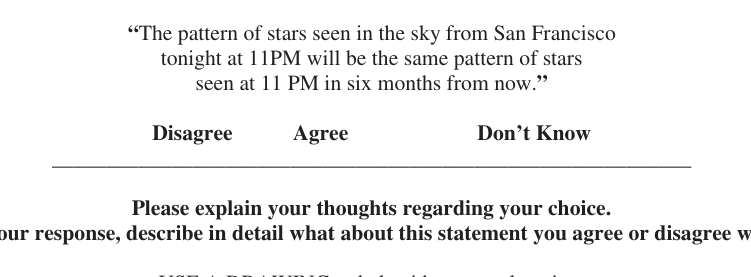
FIG. 12. Assessment used to measure students ’ ability to provide a description of how and why the night sky changes over the course of six months. The distributions of students choosing the correct multiple-choice response and attaining the minimum rubric score can be found in Fig. 5. This question was adapted from Paul Green ’ s Peer Instruction for Astronomy .